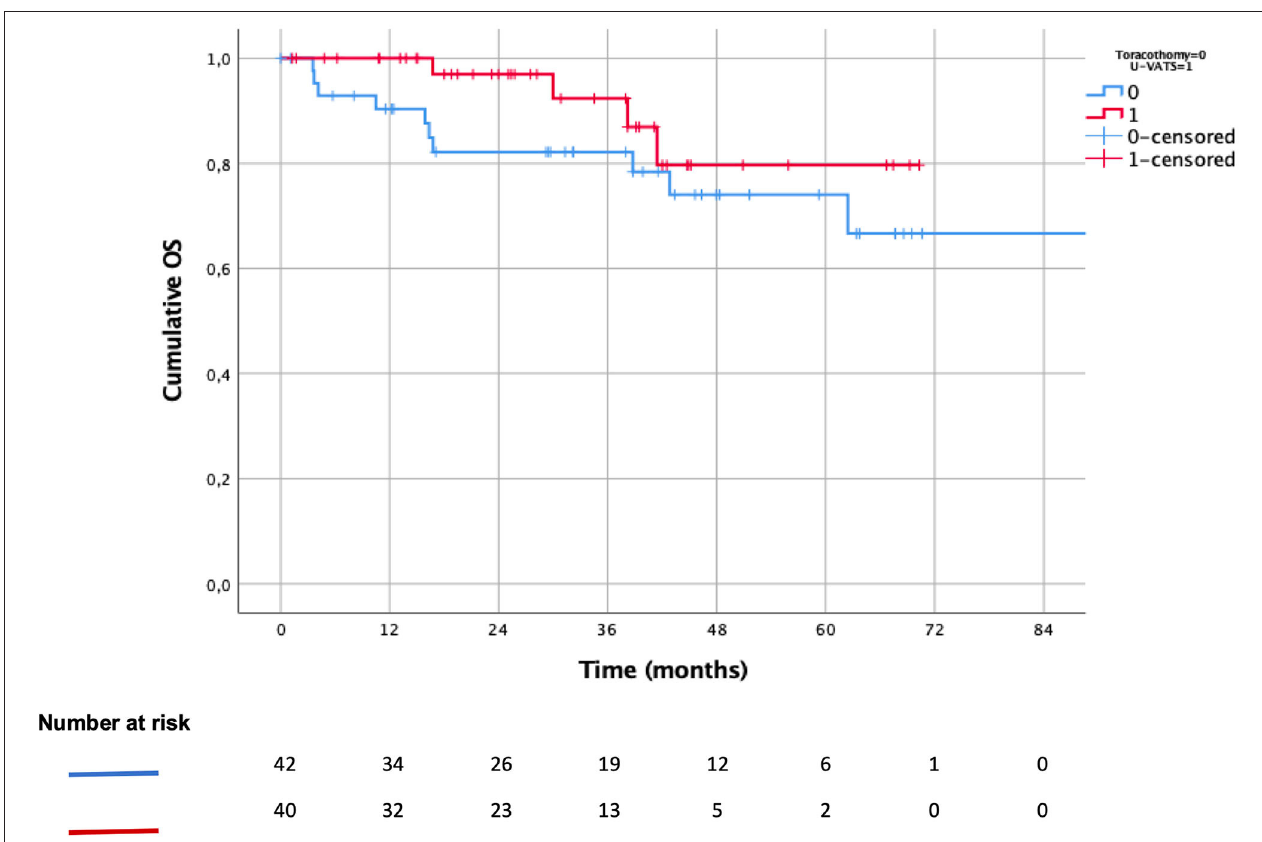
FIGURE 3 | Kaplain–Meier overall survival (OS)